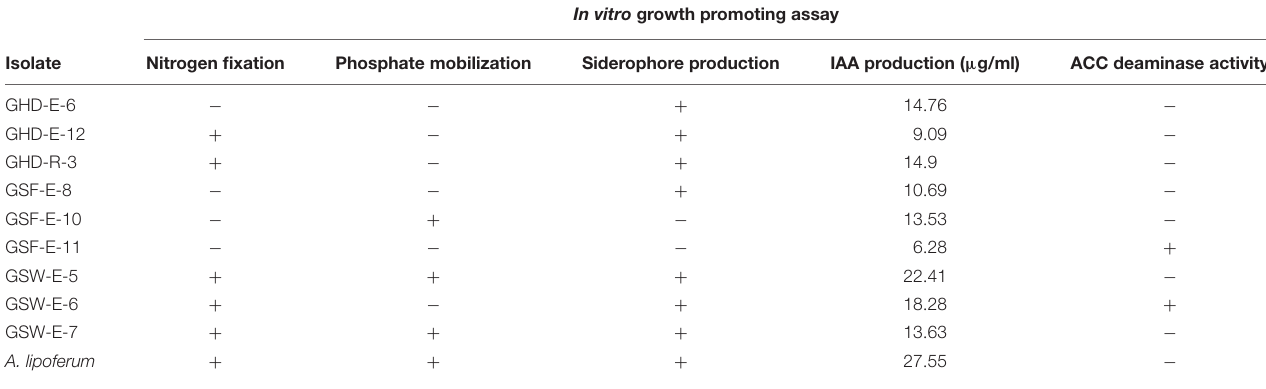
TABLE 1 | Plant growth promoting traits of nine selected strains associated with durum wheat in this study ( + indicates positive; − indicates negative). In vitro growth promoting